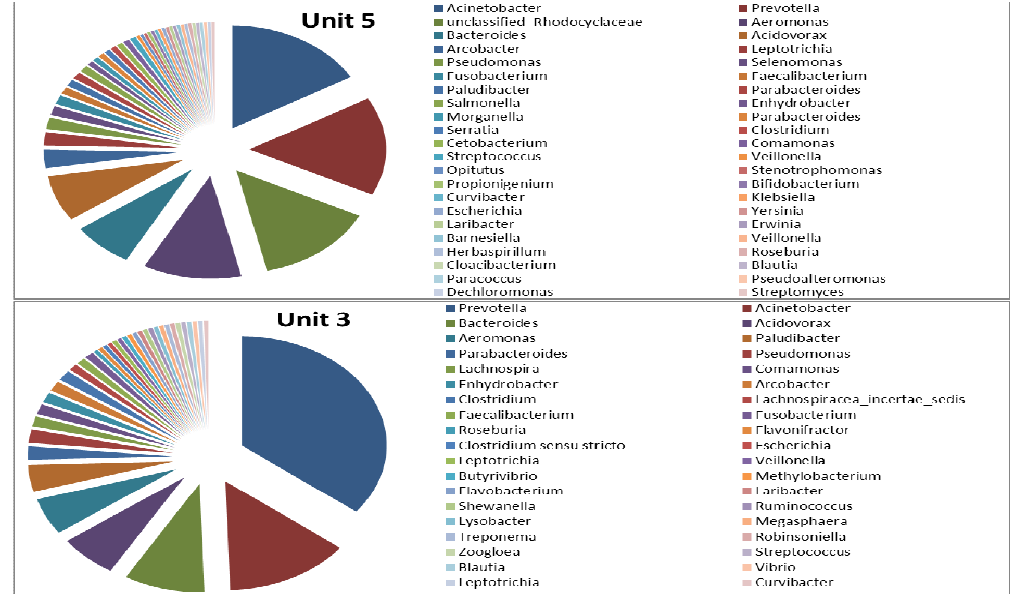
Figure 8. Microbial diversity (by genus) of elutriation tanks in Unit-5 and Unit-3 of the Northern Wastewater Treatment Works, Johannesburg, South